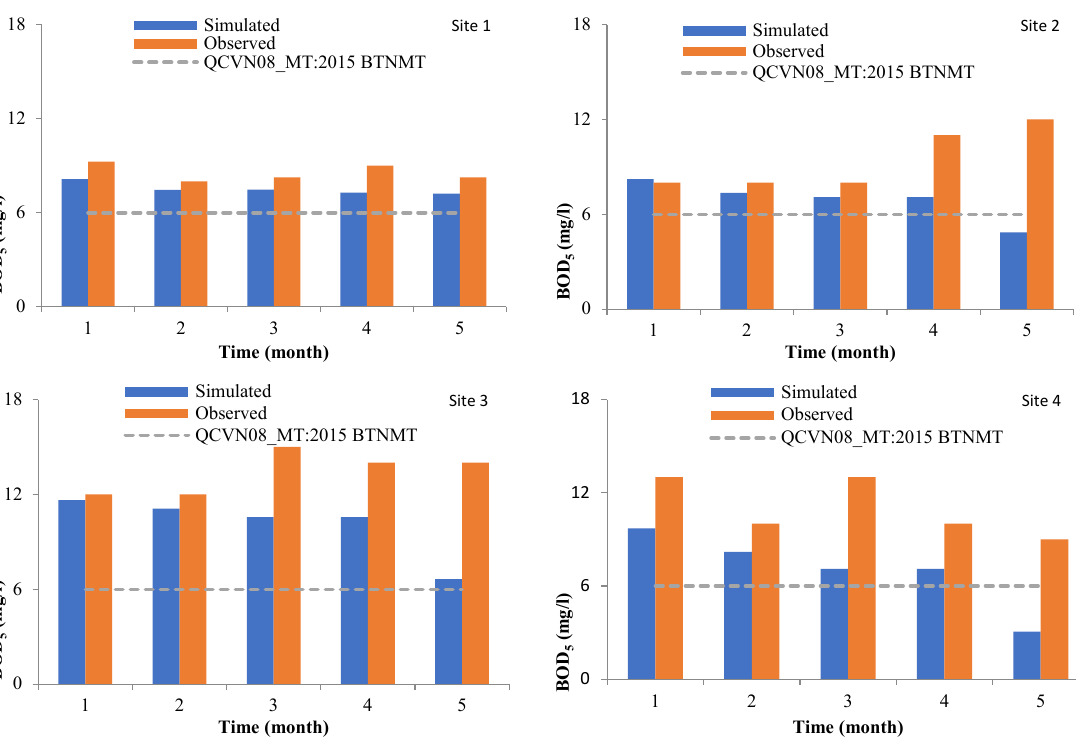
Figure 6. Calibrated results of BOD 5 concentration at the four sites within the study area for the year 2019. The National Technical Regulation on surface water quality (QCVN 08MT:2015) was approved by the Ministry of Environment and Natural Resources (MoNRE) in 2015.